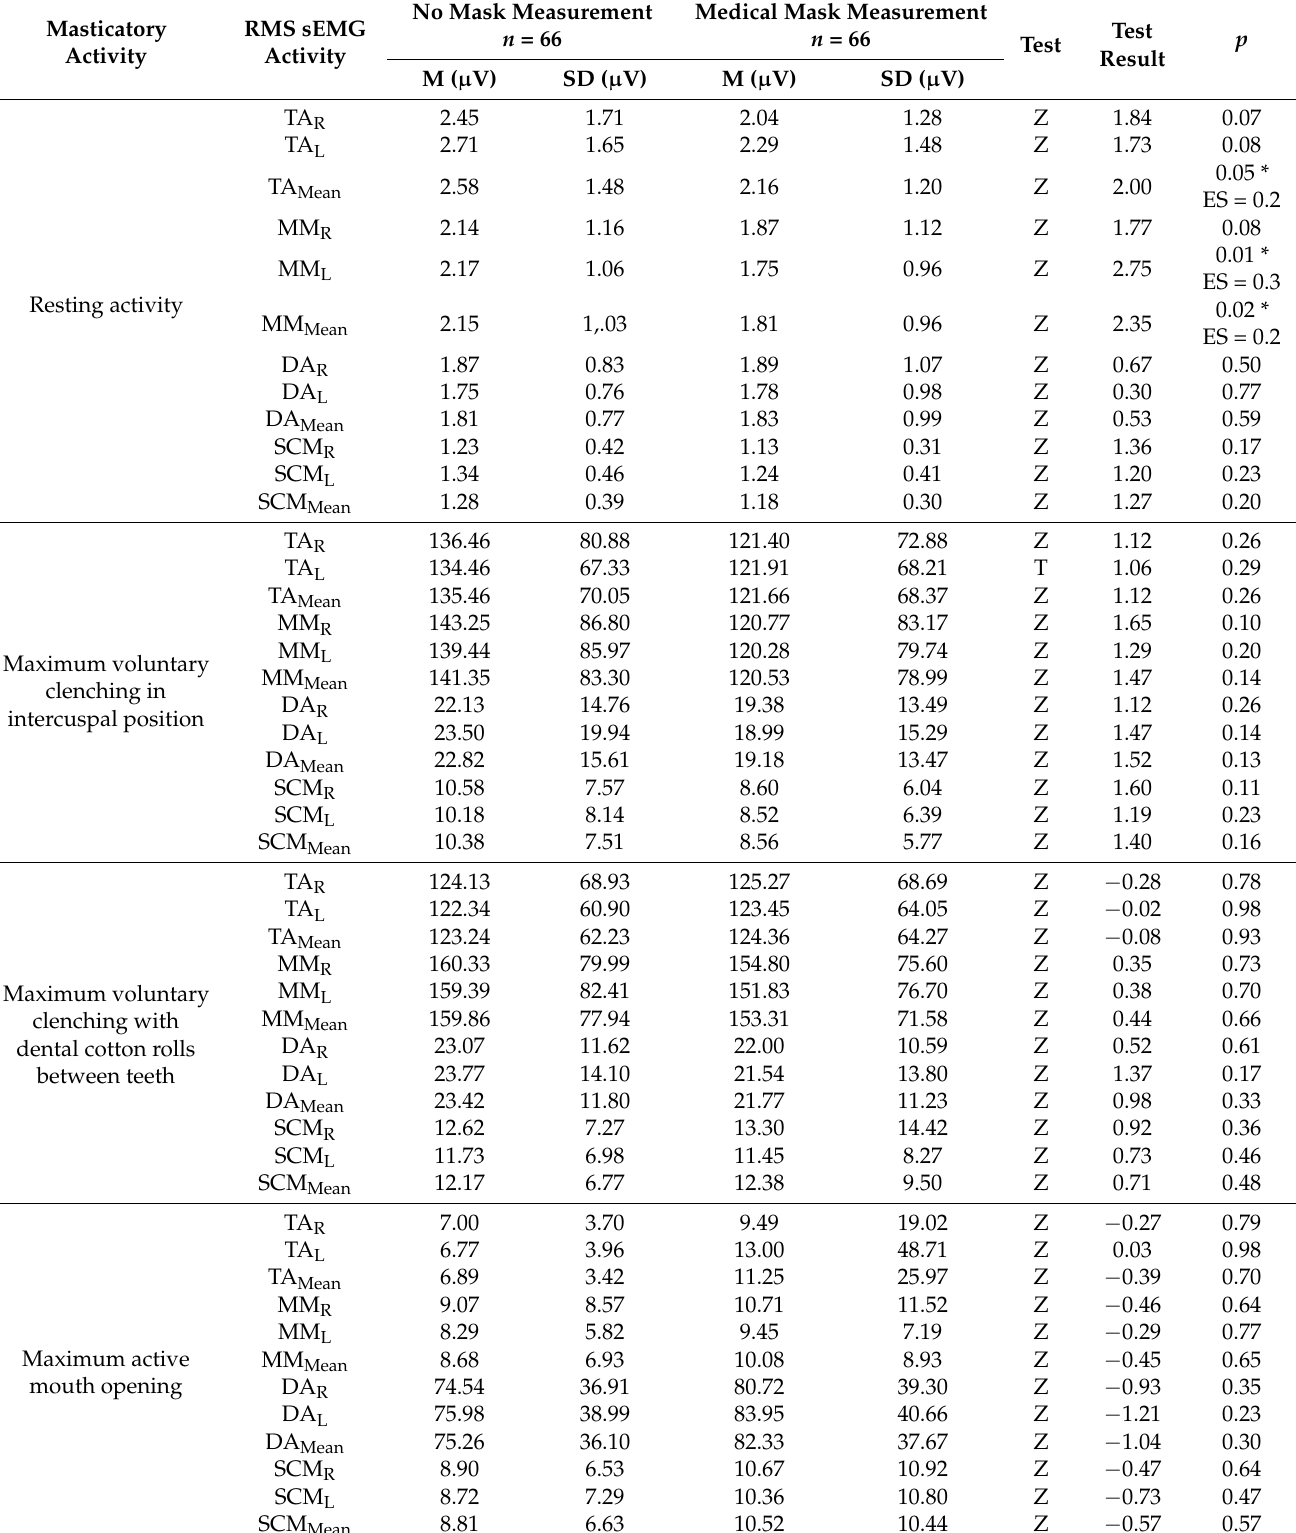
Table 1. The comparison of the root mean square (RMS) sEMG activity between no mask and medical mask